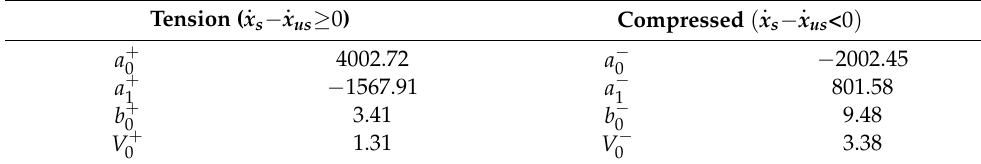
Table 1. Parameters for damping force